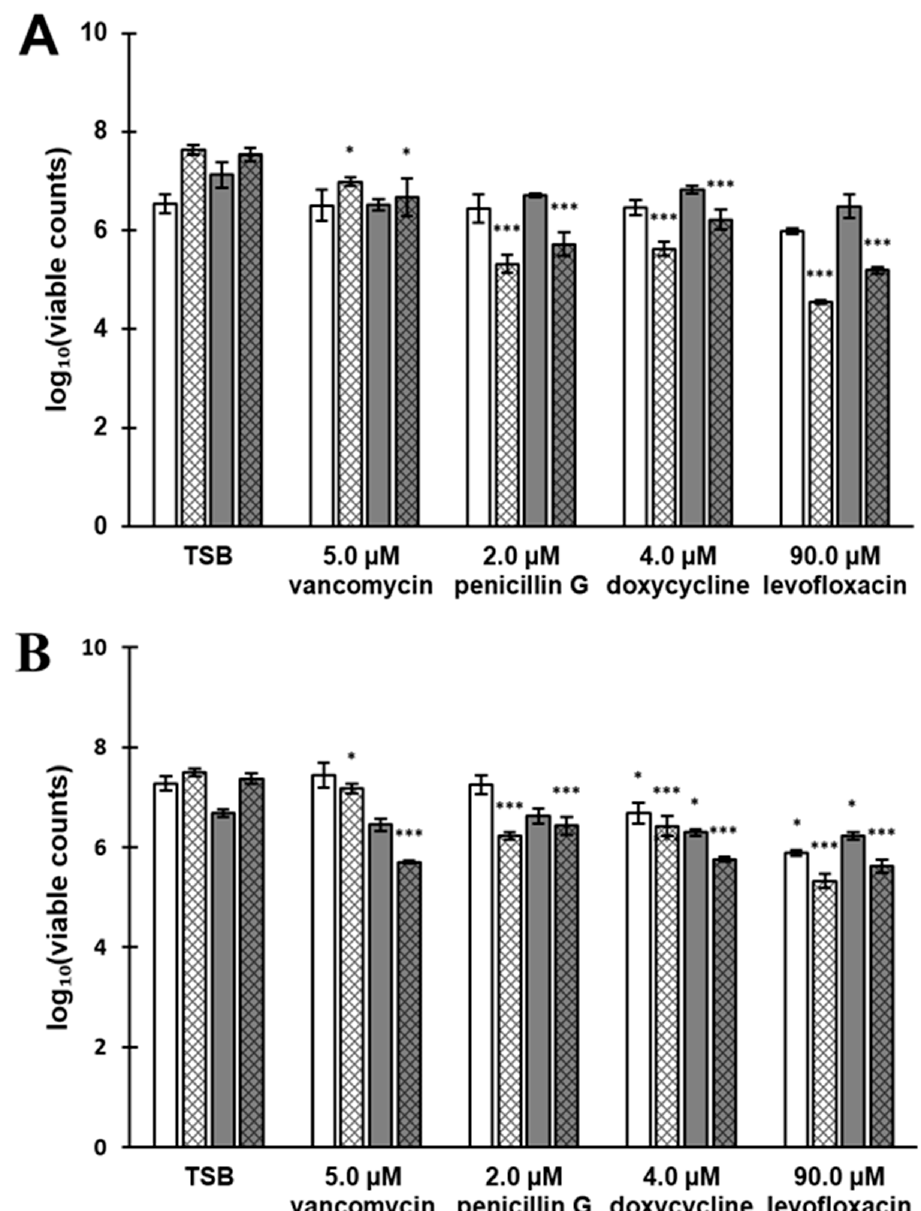
Figure 7. The chemotolerance of 18- and 66-h-old S. aureus ATCC 25923 biofilms formed on hydroxyapatite, HA ( A ) and titanium, TI ( B ) and exposed to several antibiotics for 2 or 24 h. The results are expressed as log 10 values of CFU · (mL · cm 2 ) − 1 . Plain white and dark grey bars illustrate 18- and 66-h-old biofilms (respectively) with 2-h-long antibiotic exposure, while striped white and dark grey bars illustrate 18- and 66-h-old biofilms (respectively) with 24-h-long antibiotic exposure. The results of antibiotic-treated biofilms were compared to TSB-treated biofilms. The statistical analysis was performed by using unpaired t-tests with Welch’s correction. * p < 0.05 and *** p < 0.001 were considered statistically significant and highly significant, respectively. Error bars denote the standard error of the mean (SEM) ( n = 2). A combination treatment of trypsin and levofloxacin on 18- and 66-h-old biofilms formed on HA − 1 was tested. For this purpose, biofilms were first treated with trypsin (51.9 ng · µ L ) followed by a 90 µ M levofloxacin treatment. Comparison of the results with the two controls (biofilms treated with TSB or 100 mM TEAB followed by 90 µ M levofloxacin) revealed that the trypsin treatment alone did not benefit biofilm eradication (Figure 8). Statistically highly significant di ff erences ( p < 0.001) were